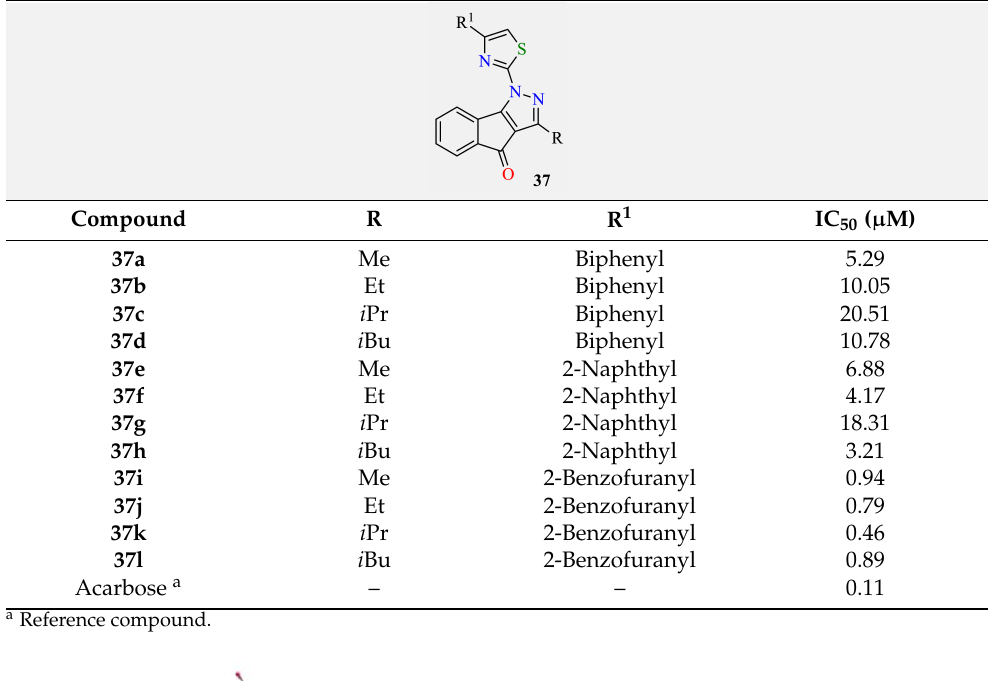
Table 47. α -Amylase activity of 3-alkyl-1-(4-(aryl/heteroaryl)thiazol-2-yl)indeno[1,2- c ]pyrazol- 4(1 H )-ones 37 .